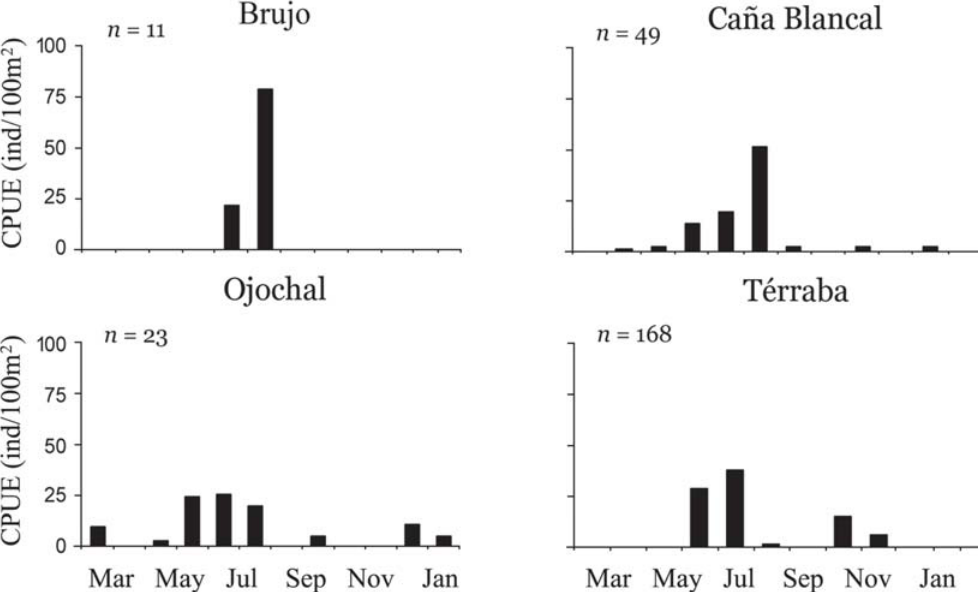
Fig. 4. Capture per unit effort (CPUE) by month for Agonostomus monticola recruits in the Térraba River and three